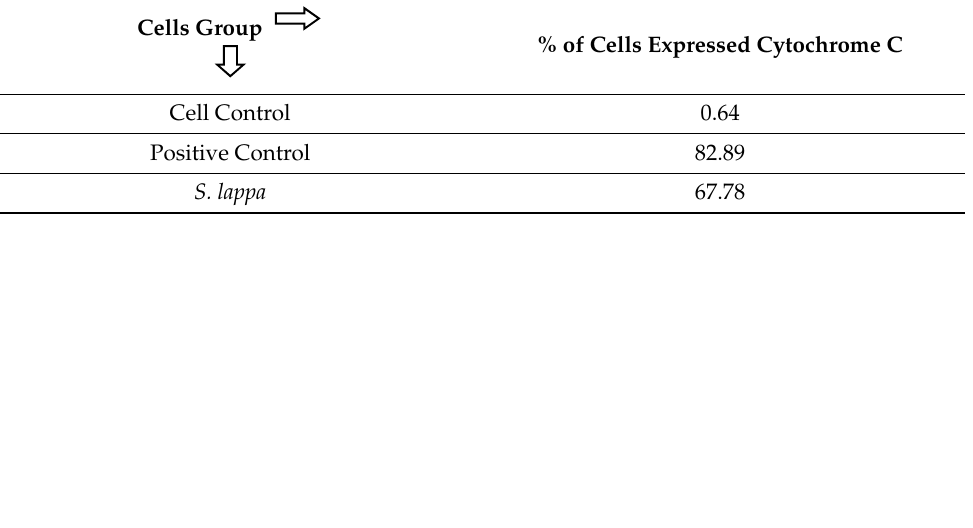
Table 5. Table showing the % of cells expressing Cyt C in Untreated, Std, and S. lappa -treated HepG2 cells.